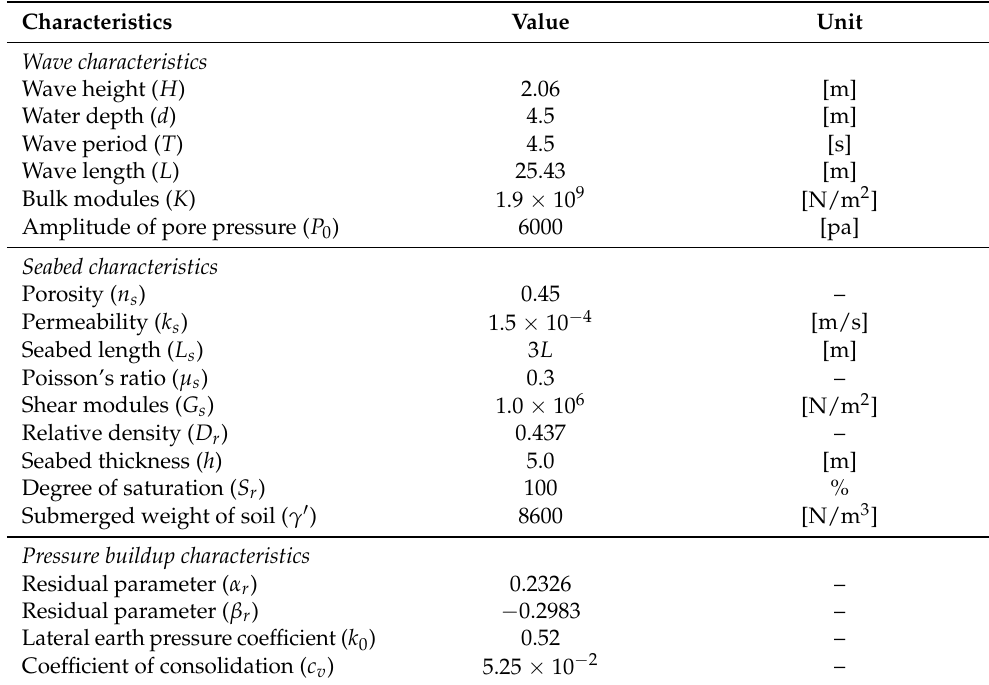
Table 3. Parameters for the second validation [18].